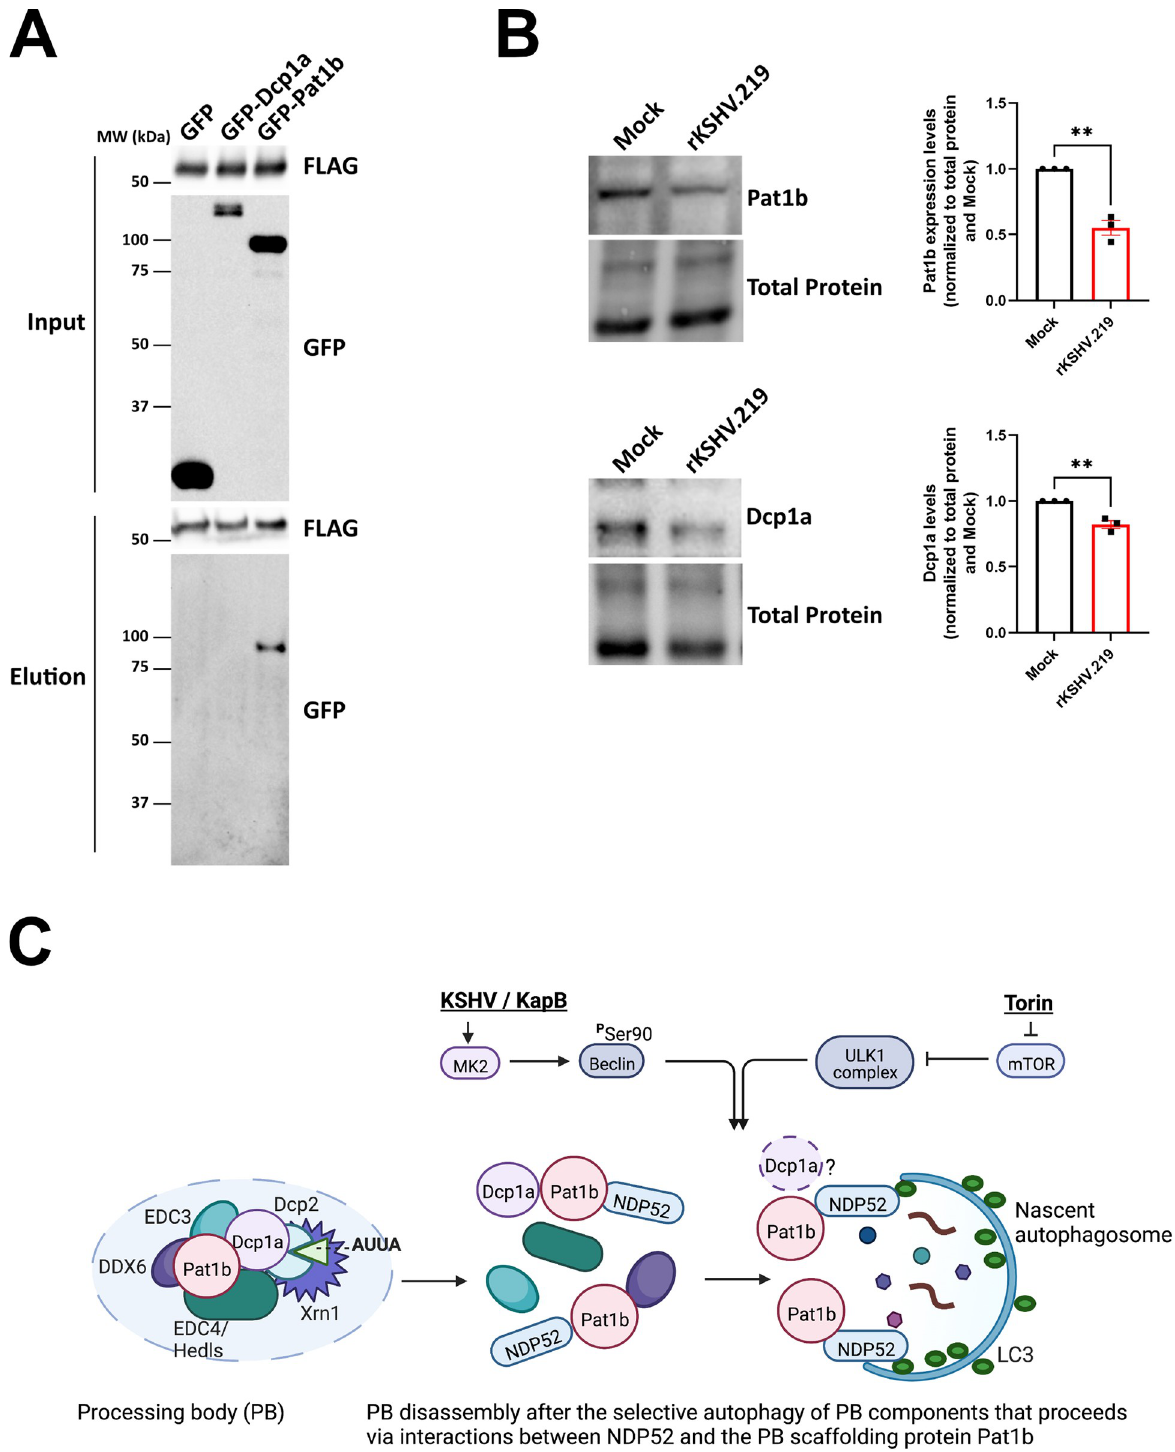
Fig 10. NDP52 immunoprecipitates with the PB resident protein Pat1b. A: HEK293T cells were transfected with plasmids expressing pcDNA-FLAG-NDP52 with either pLJM1-GFP (control), pLJM1-GFP-Dcp1a, or pLJM1-GFP-Pat1b for 48 h. Cells were harvested in lysis buffer and incubated with a FLAG mouse antibody (CST) overnight at 4˚C. Immunoprecipitation was performed and samples were eluted from the magnetic beads through boiling in 4X Laemmli buffer (BioRad) with 10% v/v beta-mercaptoethanol. Samples were resolved by SDS-PAGE. A representative blot of three independent experiments is shown. B: HUVECs were infected with rKSHV.219 via spinoculation and infection was